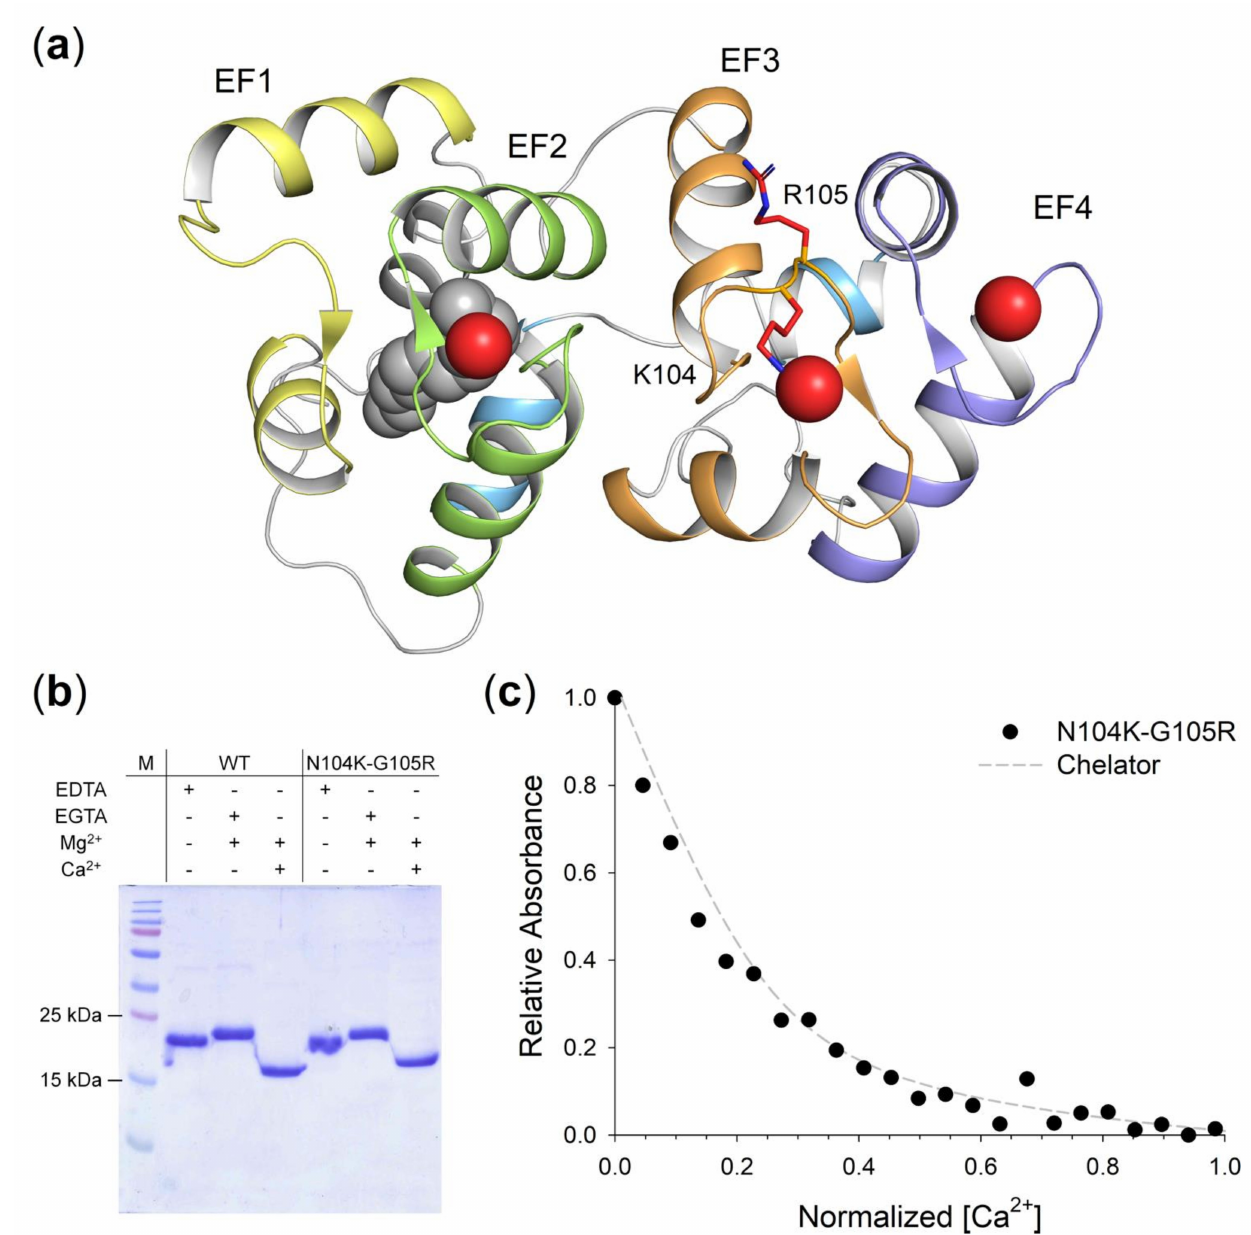
Figure 4. Structural model of N104K-G105R GCAP1 and assessment of Ca 2+ -affinity of GCAP1 variants. ( a ) 3D structural model of human N104K-G105R GCAP1 in the Ca 2+ -loaded form. Protein structure shown in cartoon form, with structural regions specifically colored (N-terminal helix grey, EF1 yellow, EF2 green, EF3 orange, EF4 blue, C-terminal helices cyan). Myristoyl moiety is represented as grey spheres, Ca 2+ ions as red spheres, residues K104 and R105 as red sticks, with N atoms in blue. ( b ) 15% SDS-PAGE of 20 µ M GCAP1 WT and N104K-G105R variants in the presence of 5 mM EDTA, 5 mM EGTA + 1.1 mM Mg 2+ or 1 mM Mg 2+ + 5 mM Ca 2+ . ( c ) Example of Ca 2+ titration curve for N104K-G105R GCAP1. Normalized absorption of 5,5 (cid:48) Br 2 -BAPTA upon Ca 2+ -binding in competition with N104K-G105R GCAP1 (black circles) in the presence of 1 mM Mg 2+ , together with the theoretical simulated curve of the chelator in the absence of competition (grey dashed line). Ca 2+ -concentration considers the dilution upon Ca 2+ -addition, normalization details are reported in the Methods